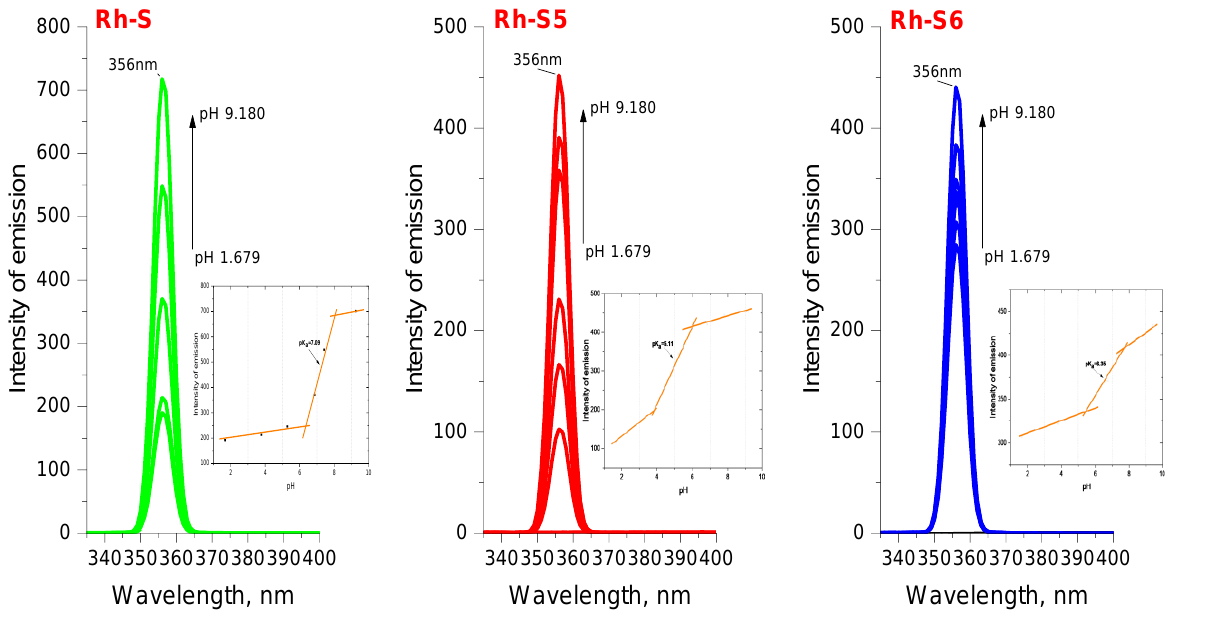
Figure 6. Emission spectra of spinorphin derivatives at λ ex = 275 nm and different pHs. The inset plots represent I(emission)/pH obtained from the emission spectra of the respective compounds.